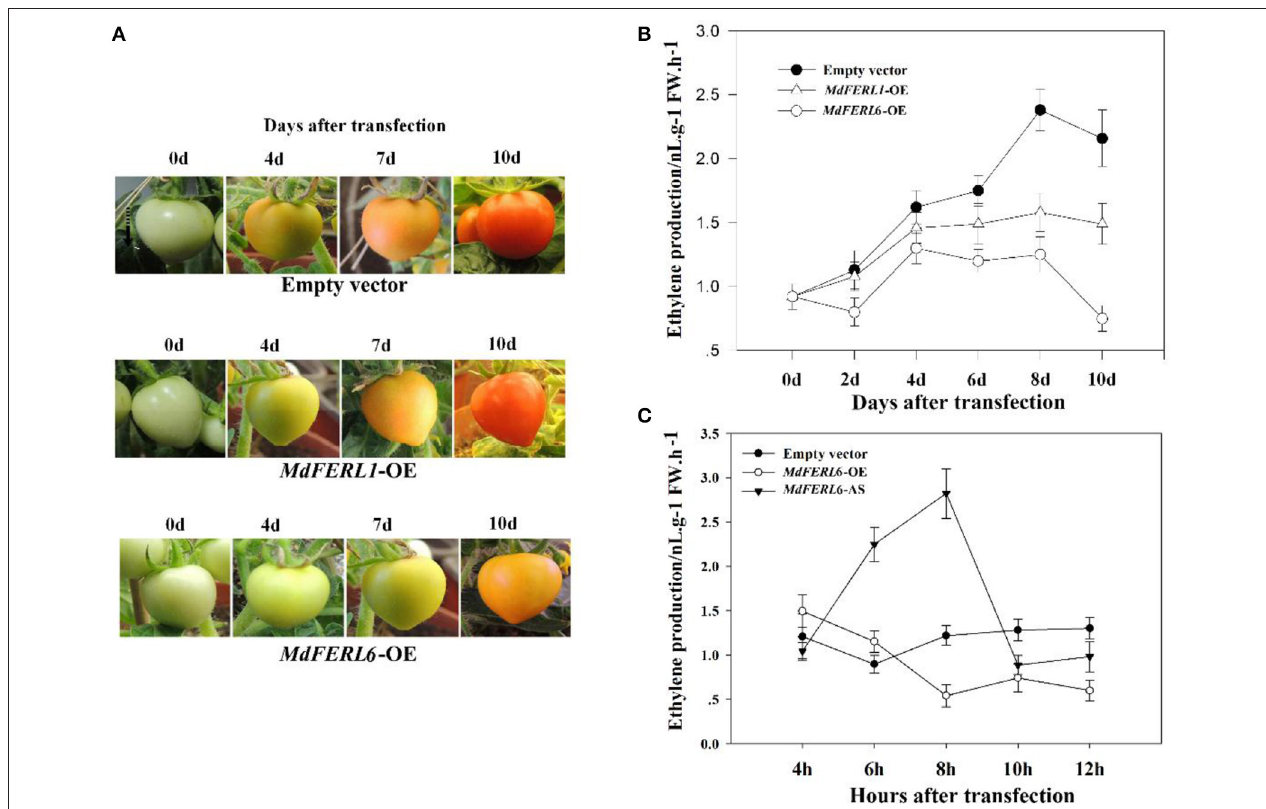
FIGURE 4 | Effect of MdFERL1 and MdFERL6 overexpression (OE) and SlFERL1 -VIGS (virus-induced gene silencing) on transgenic tomato fruit ripening. (A) The influence of MdFERL1 -OE and MdFERL6 -OE on the time course of tomato fruit development and ripening. (B) The effect of MdFERL1 -OE and MdFERL6 -OE on tomato fruit ethylene production. (C) The effect of MdFERL6 -OE and MdFERL6 -AS on apple ( Malus × domestica ) callus ethylene